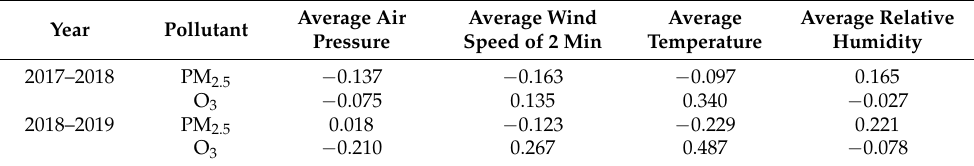
Table 3. Kendall’s tau coefficient between pollution concentrations and meteorological.